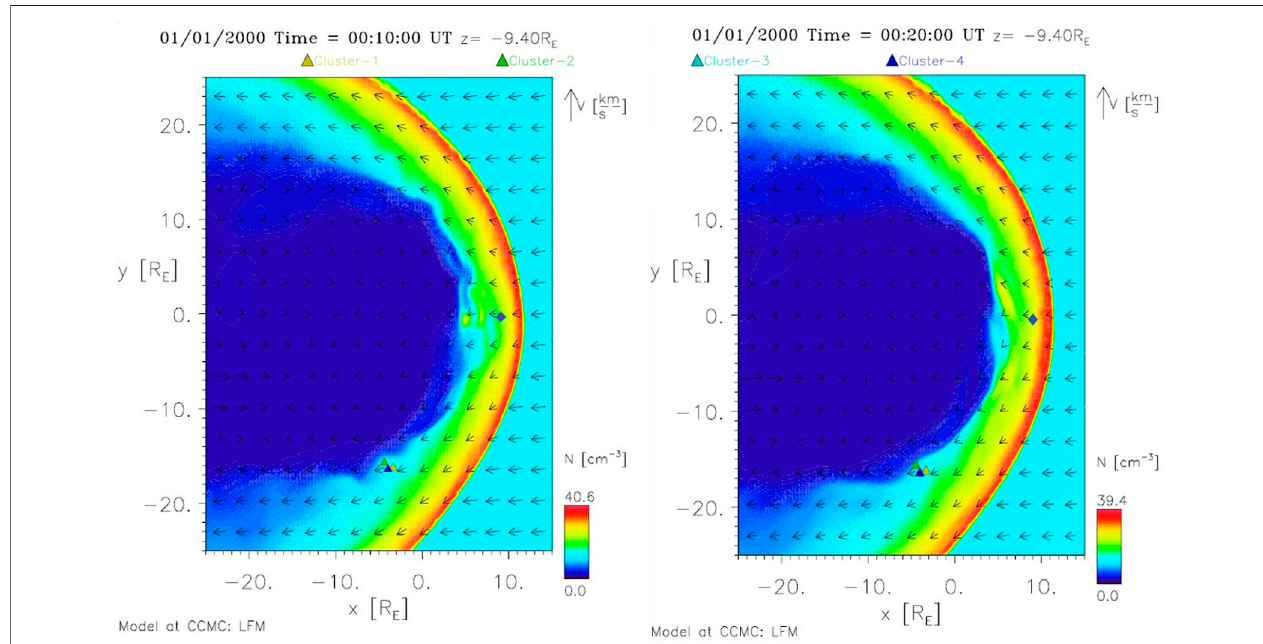
FIGURE 13 | Snapshot of the Global MHD (LFM-model) simulation in Solar Magnetic coordinates, driven with constant IMF orientation and without solar wind dynamicpressurevariations, inthe XY -planewith Z (cid:1) − 9.4R E (solarmagneticcoordinates)forconditionscharacteristicofJuly3,2007between 1600and 1730UT. The fi gure on the left shows a snapshot taken at 10 min into the simulation, and the fi gure on the right shows a snapshot taken at 20 min. Colors represent plasma density (see color bar), arrows represent plasma velocity, and the triangles show the location of the four Cluster spacecraft. The purple diamond denotes the approximate ( X , Y ) location of the THEMIS-E spacecraft (with Z GSE ≈ − 2.4 R E